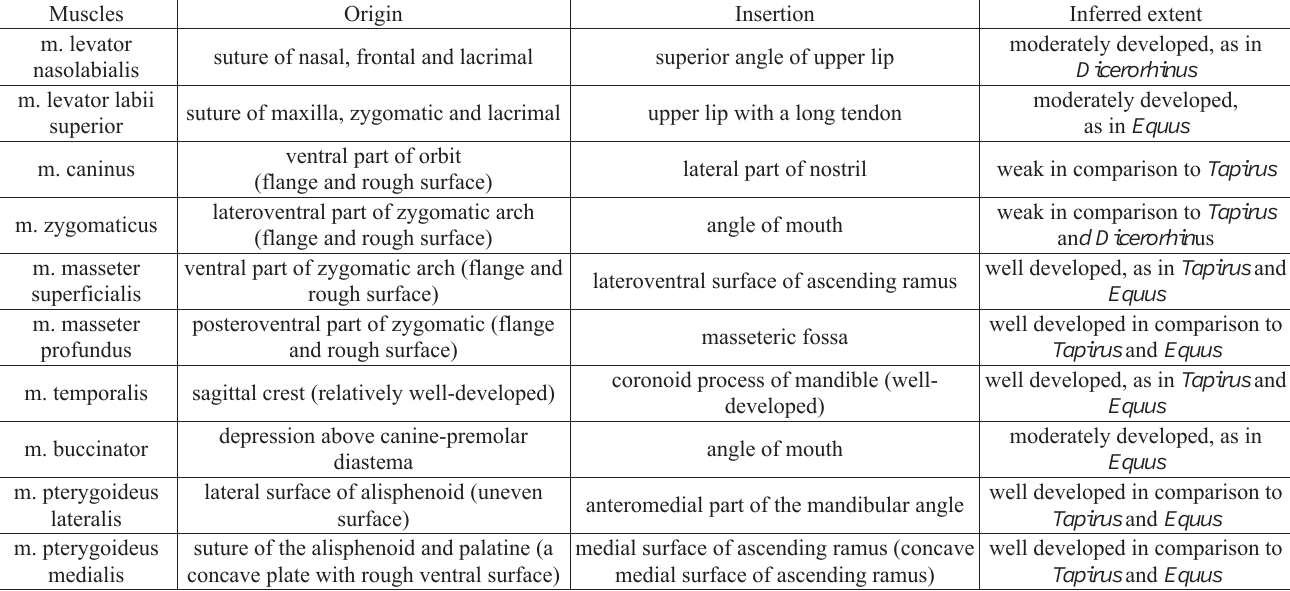
Table 2. Cranial muscles of Pappaceras meiomenus reconstructed based on inferred